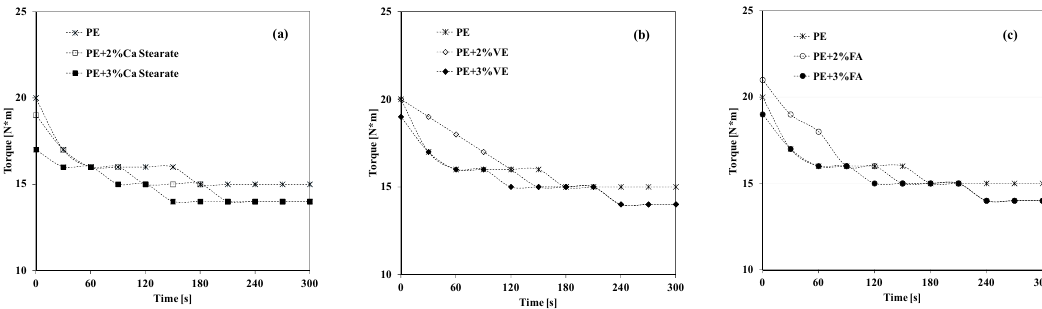
Figure 1. Torque trends of neat PE and PE containing different compounds as a function of the processing time. ( a ) Ca stearate; ( b ) Vitamin E; ( c ) Ferulic Acid.